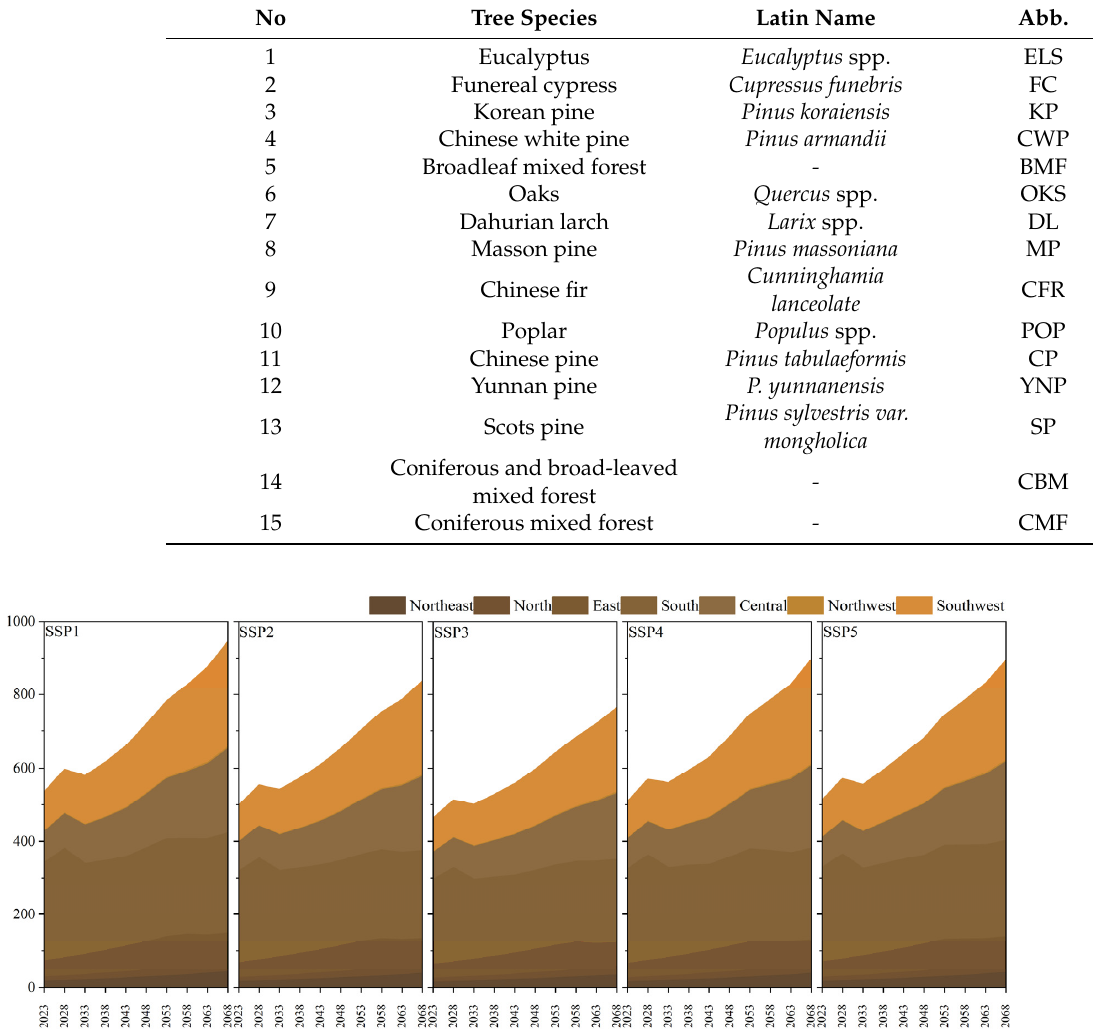
Table A4. Abbreviations of tree species.